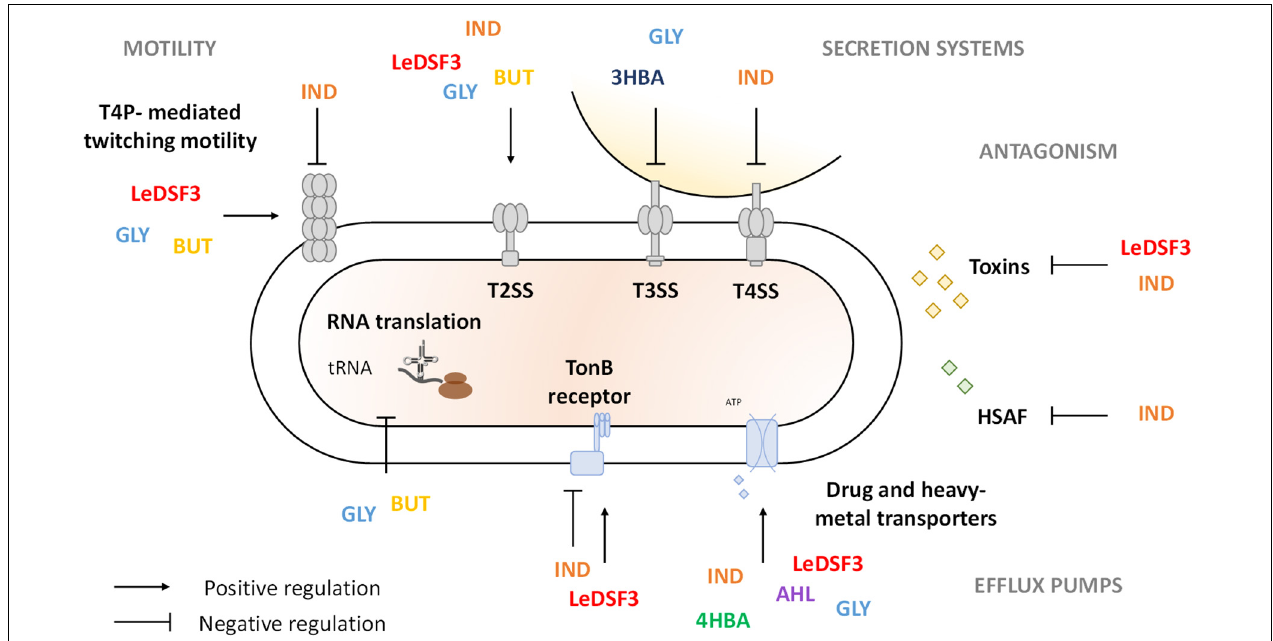
FIGURE 4 | Schematic representation of Lysobacter capsici AZ78 response to diffusible communication signals. LeDSF3, 13-methyltetradecanoic acid; IND, indole; GLY, glyoxylic acid; BUT, 2,3-butanedione; 3HBA, 3-hydroxybenzoic acid; 4HBA, 4-hydroxybenzoic acid; AHL, N -acyl-homoserine lactones.